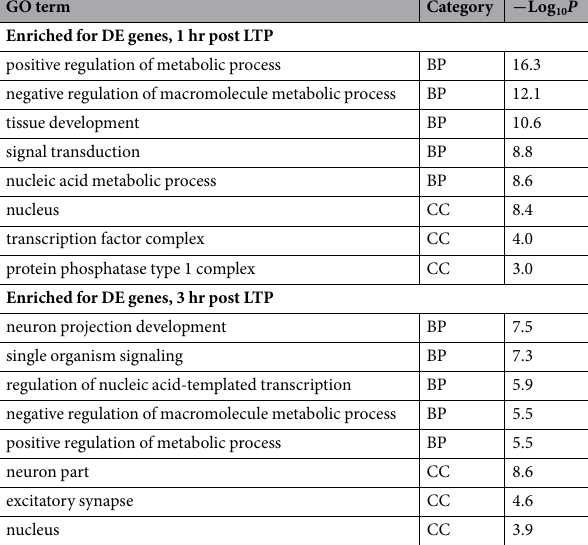
Table 2. GO terms enriched for upregulated and downregulated genes 1 hr or 3 hr post LTP induction. BP, biological process; CC, cellular component. P is based on the Fisher’s exact